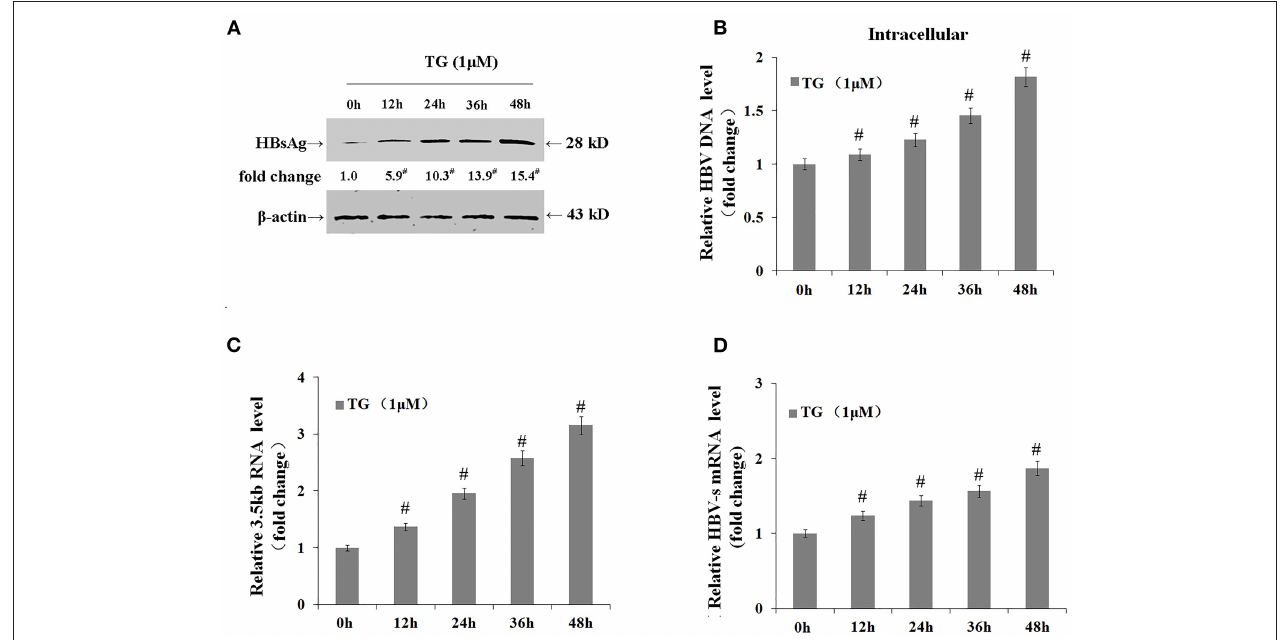
FIGURE 4 | Thapsigargin (TG) promoted hepatitis B virus (HBV) DNA transcription and the accumulation of HBV DNA and HBsAg in HepG2.2.15 cells. HepG2.2.15 cells were treated with 1 µ M of TG for 12, 24, 36, and 48h. Intracellular HBsAg, HBV DNA, and HBV RNA levels were determined by western blotting, qPCR, and real-time RT-qPCR, respectively. The results are presented as fold-changes compared with the control. Histograms represent the means ± SD of three independent experiments. # P < 0.05 vs. control. (A) HBsAg levels as determined by western blotting. Representative blots from three independent experiments are shown. (B) HBV DNA levels as determined by qPCR. (C) HBV 3.5-kb mRNA levels as determined by RT-qPCR. (D) HBV S mRNA levels as determined by